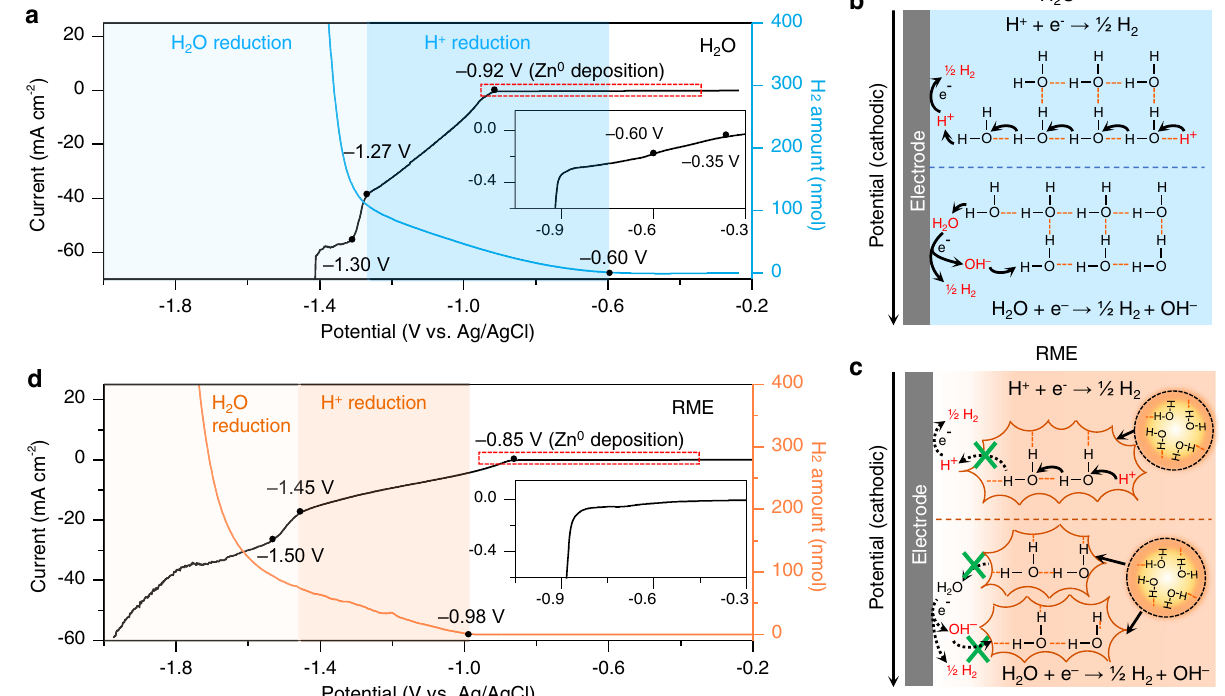
Fig.1|Thecathodicstabilityofthe3mZn(OTf) 2 /H 2 O(H 2 O)electrolyteandthe RME and corresponding proton transport mechanism. a Cathodic stability and H 2 coevolution behavior for the H 2 O electrolyte determined by LSV and operando gas pressure measurement. b Schematic illustration of proton transport via the Grotthuss mechanism in the H 2 O electrolyte. c Schematic illustration of the